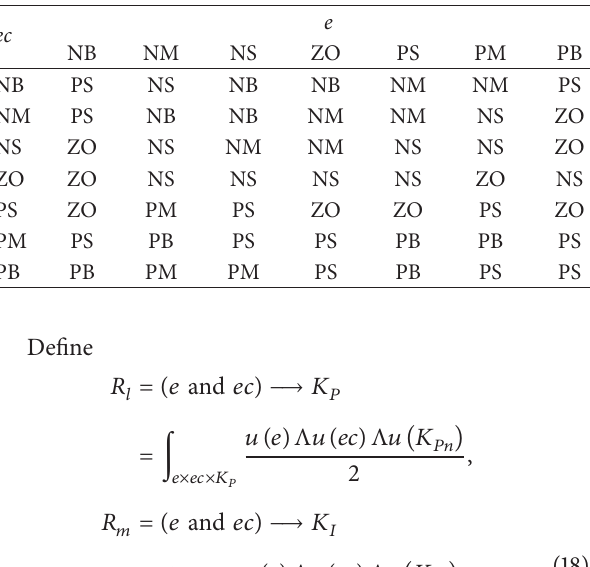
Table 3: Fuzzy logic rule for Δ𝐾 𝐷 .